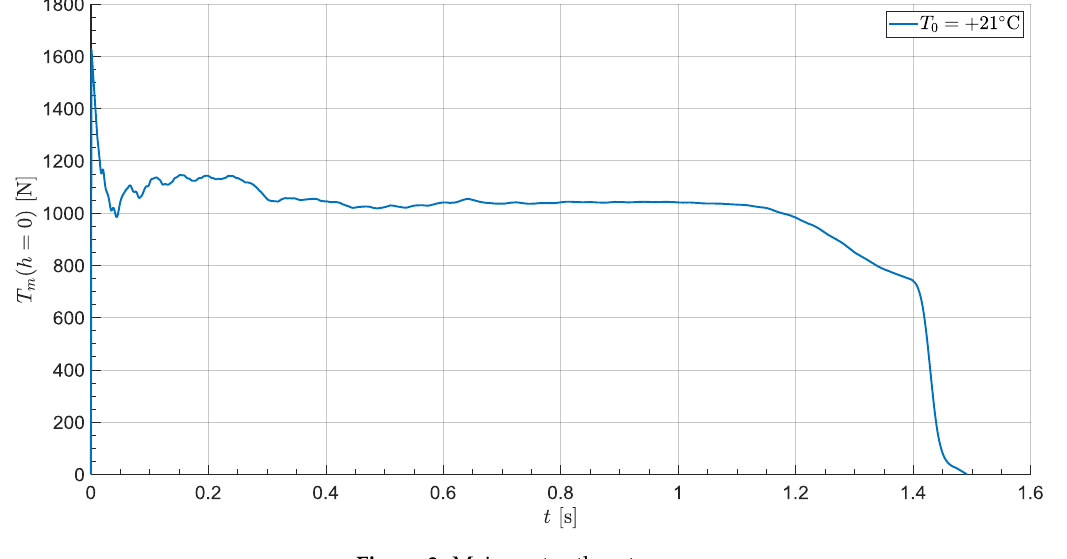
Figure 3. Main motor thrust curve.